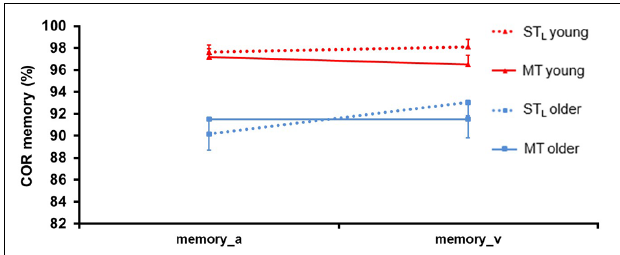
FIGURE 11 | Correctness (COR) ± SE in the memory task for both age groups in single task (ST D ) and multitask (MT) conditions. The memory task was presented auditorily (a) and visually (v).